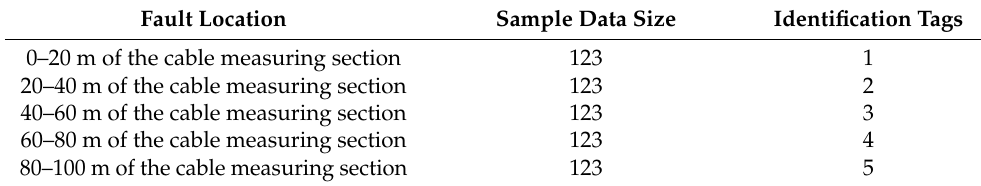
Table 4. Sample volume and code of cable fault locations.